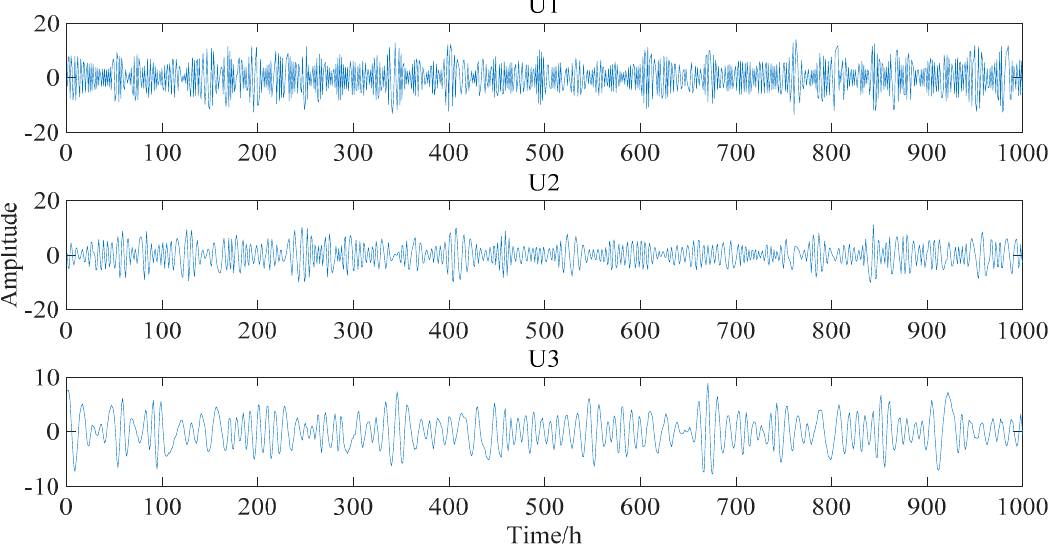
Figure 12. Three basis vectors after PCA.( U1, U2 and U3 are the first three eigenvectors)